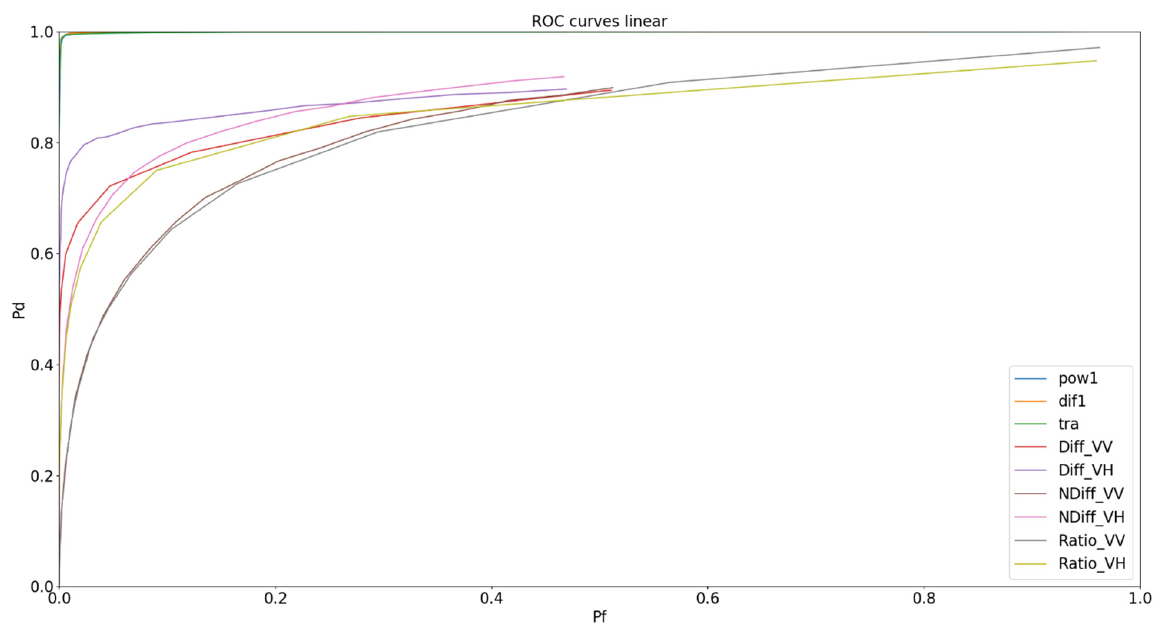
Figure 10. ROC curve in linear format showing change detectors used on 19 January 2020 barrage & 24 April 2020 data: Difference VV and VH (Diff_), Ratio VV and VH (Ratio_), Normalised Difference (NDiff_), Power Difference (Dif1), Power Ratio (Pow1) and Trace (HLT).